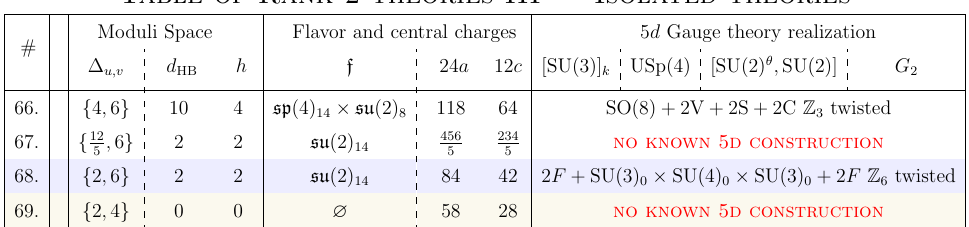
Table of Rank-2 theories III | Isolated theories